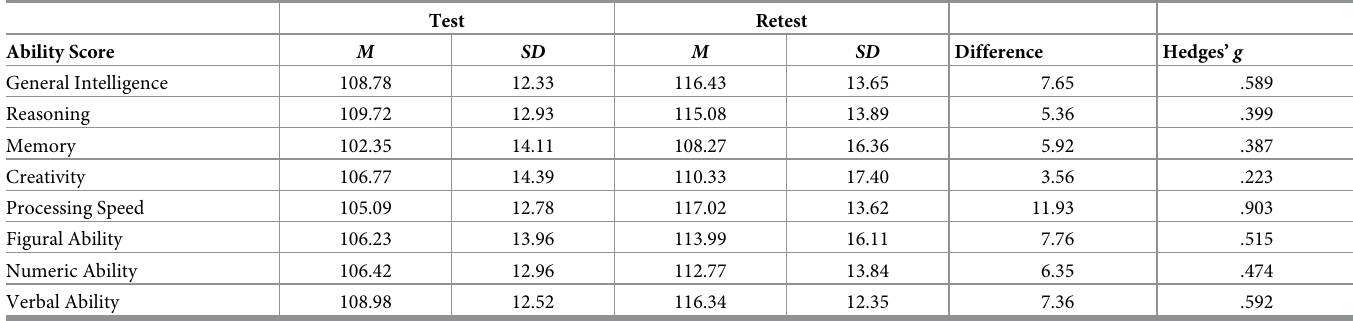
Table 7. Means and standard deviations of BIS-HB specific ability scores across a test–retest interval of ten